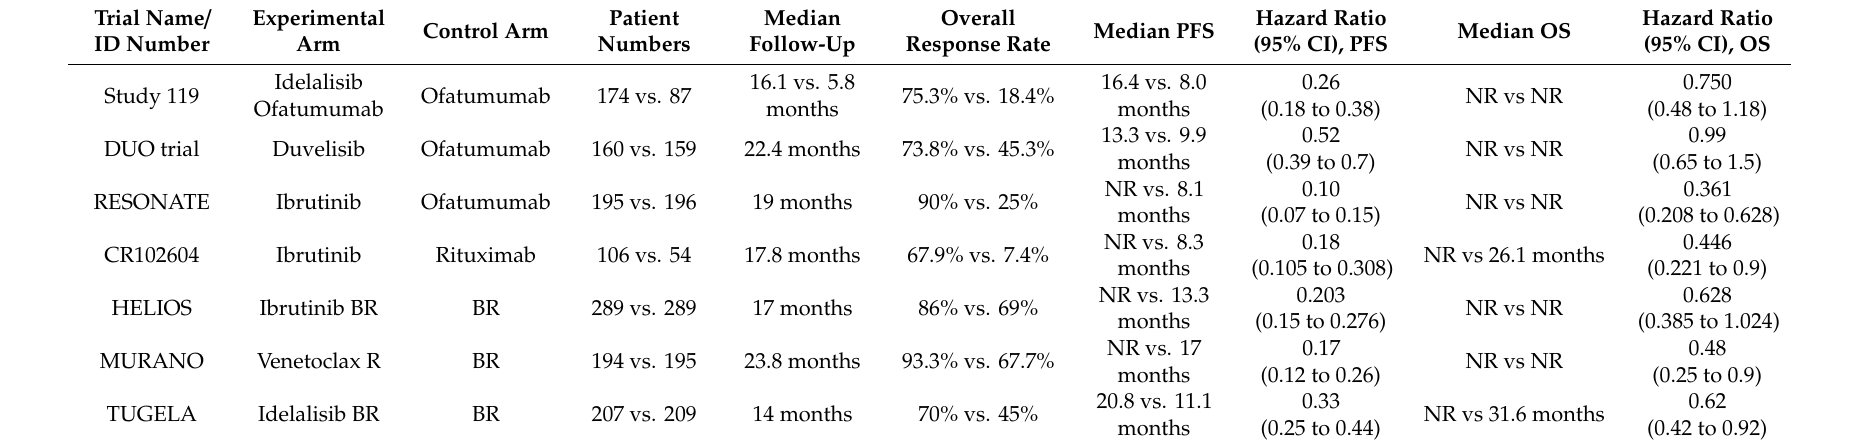
Table 2. Extracted data of included randomized controlled